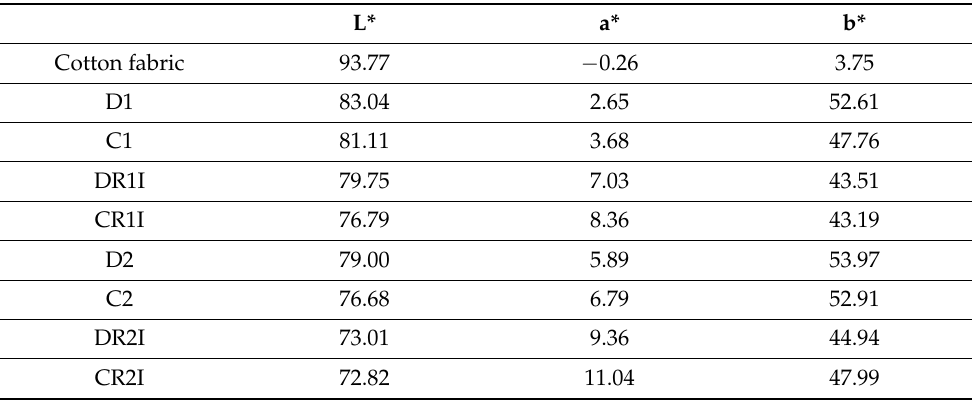
The data for the color space coordinates (light–dark (L*), red − green (a*) and yel- low − blue (b*) values) of the samples were compared and are shown in Table 2 .